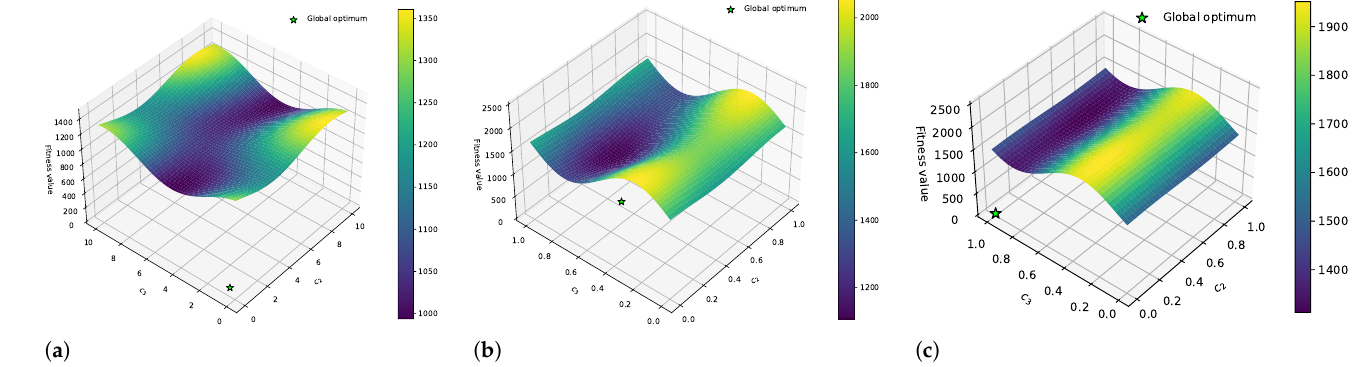
Figure 8. Effect of the surrogate modeling on the fitness landscape of the MM model. ( a ) Surrogate model of the original fitness landscape. ( b ) Surrogate model of the fitness landscape dilated by means of the anti-log DF. ( c ) Surrogate model of the fitness landscape dilated by means of the evolved